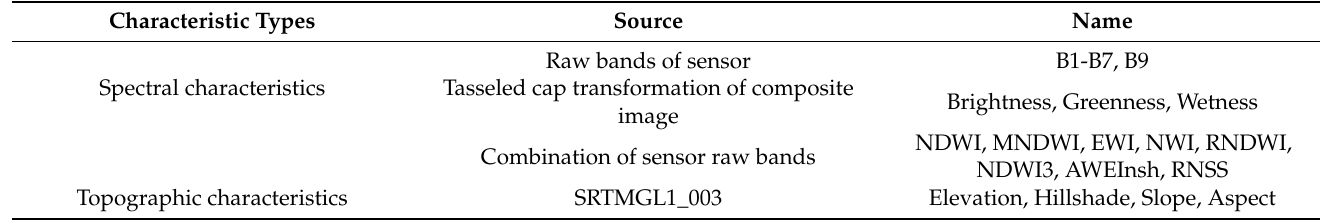
Table 2. Characteristic Indexes of Lake extraction in the Tibetan